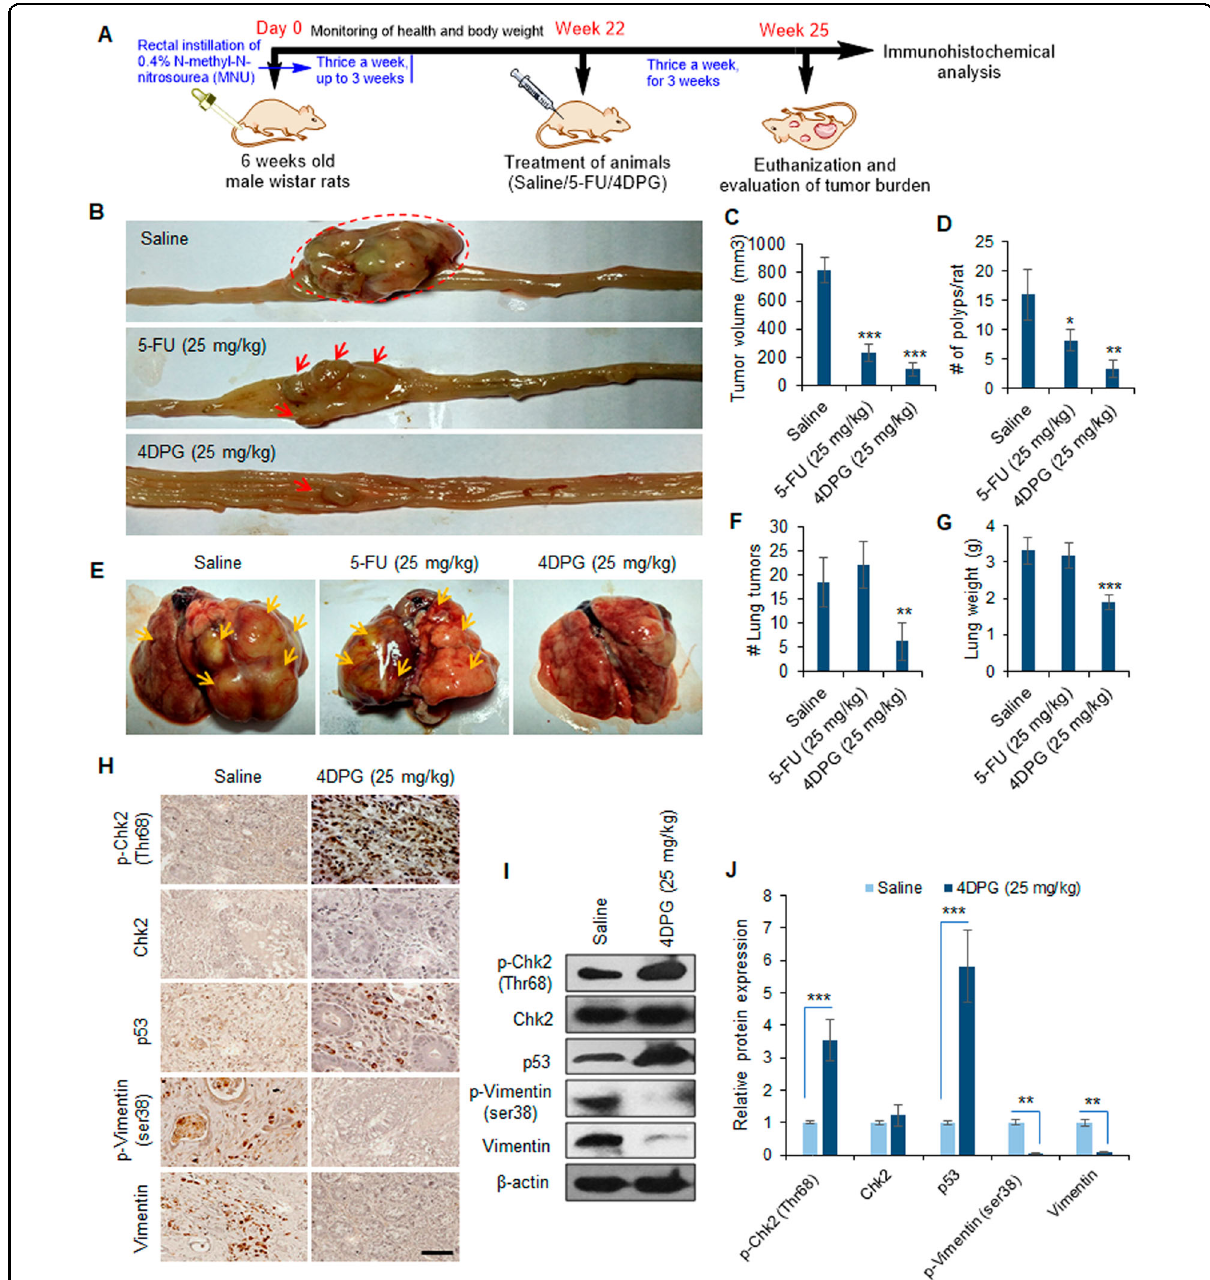
Fig. 4 4DPG inhibits tumor growth and lung metastases in orthotopic rat CRC model. A Model depicting the procedure adopted for generating the carcinogen-induced orthotopic rat CRC model, treatment strategies of 4DPG, evaluation of tumor burden, and further biochemical analysis. B Representative images of large bowel showing the colorectal tumor growth in saline, 5-FU (25 mg/kg), and 4DPG (25 mg/kg) treated groups of animals. C , D Quanti fi cation of tumor volume and number of polyps per rat in above groups of animals. n = 6 rats per group, error bars: mean ± SD; * P < 0.05, ** P < 0.01, *** P < 0.001. E Representative images of the lungs dissected from the above groups of animals showing metastatic tumor burden. Orange arrows indicating bumps of secondary tumors over each lobe of lungs. F , G Quanti fi cation of a number of macroscopic secondary tumors over the lung tissues and lung weight in the above groups of animals. n = 6 rats per group, error bars, mean ± SD; ** P < 0.01, *** P < 0.001. H Immunohistochemistry analysis results showing protein expression of p-Chk2 (Thr68), Chk2, p53, p-Vimentin (Ser38), and Vimentin in tumor tissues isolated from saline and 4DPG (25 mg/kg) treated groups of animals. Scale bar: 50 µm. I Western blots depicting expression of p-Chk2 (Thr68), Chk2, p53, p-Vimentin (Ser38), and Vimentin in tumor tissues obtained from saline- and 4DPG-treated groups of animals. β -Actin expression was taken as endogenous loading control. J Densitometry analysis of the above western blot bands portraying relative protein expression of the markers presented. n = 3, error bars: mean ± SD; ** P < 0.01, *** P <